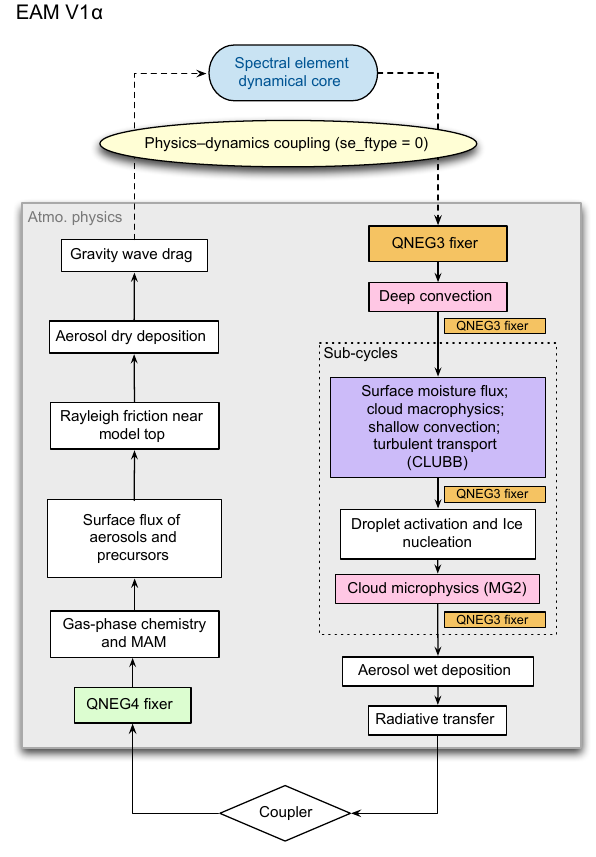
Figure C1. Similar to Fig. 1, but for the V1 α version of EAM. The diagram for V1 β is the same except that the physics–dynamics cou- pling uses se_ftype =